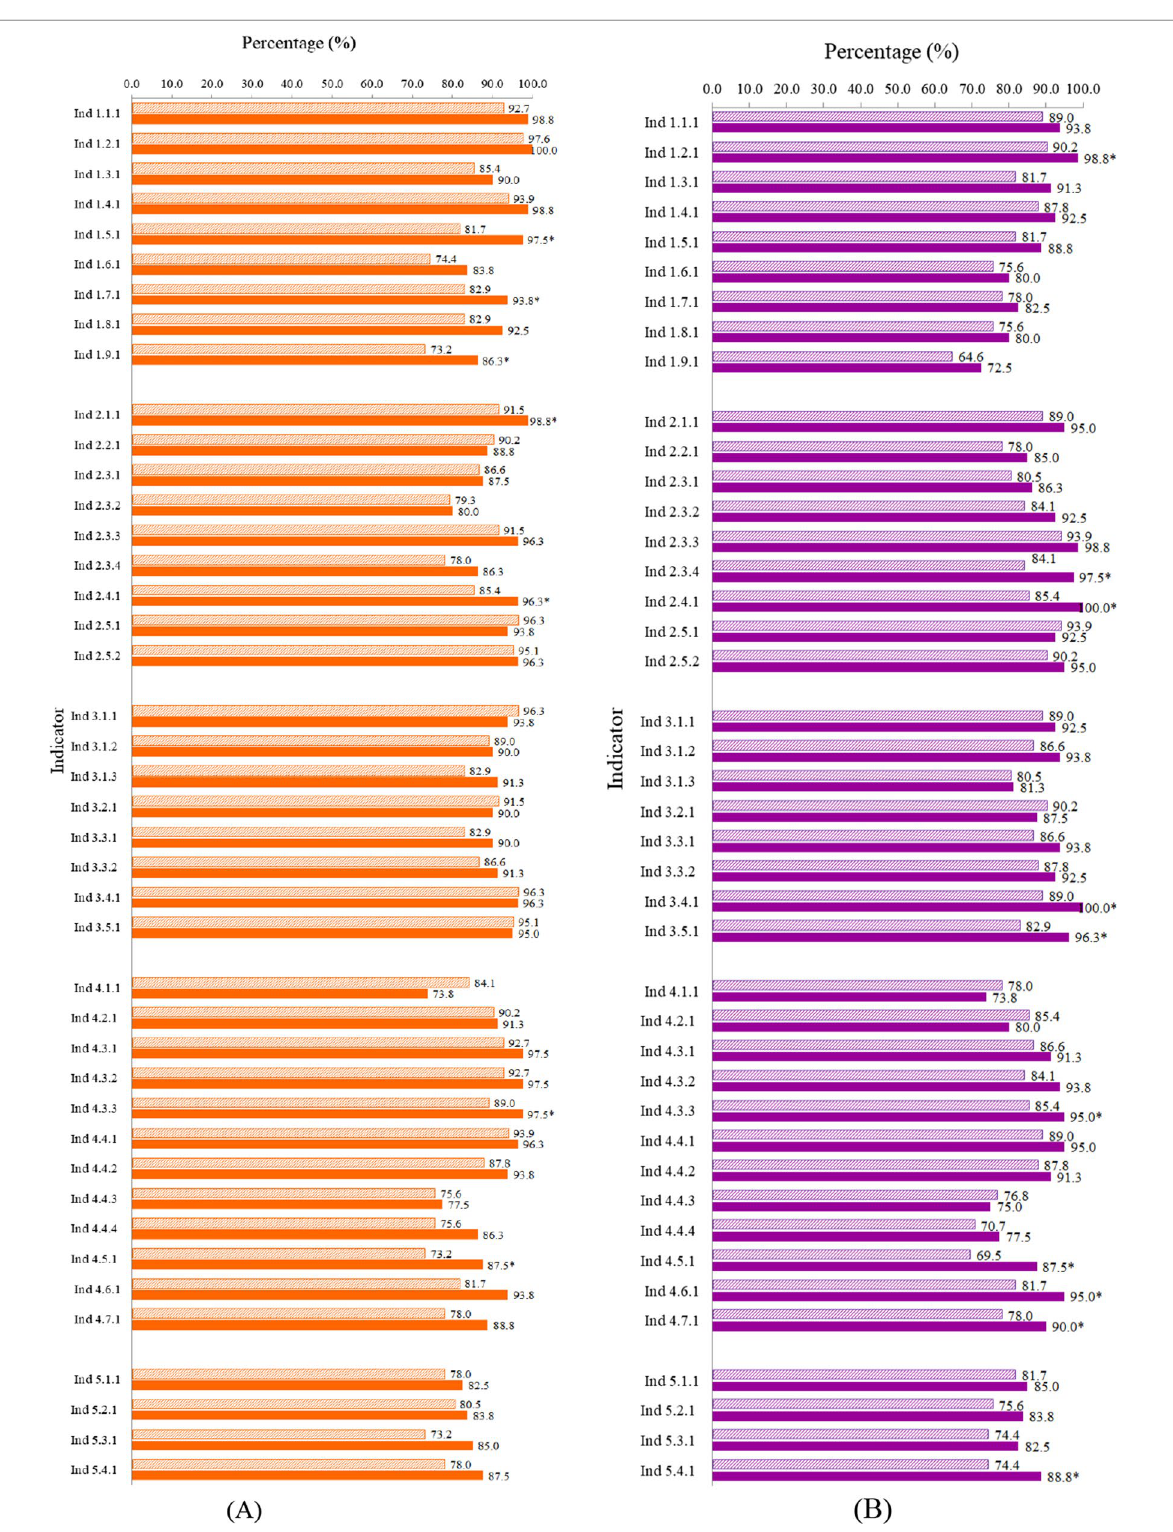
Fig. 2 The percentages of experts who considered the necessities or feasibilities were “Very good” or “Good”. Note “Ind” represents